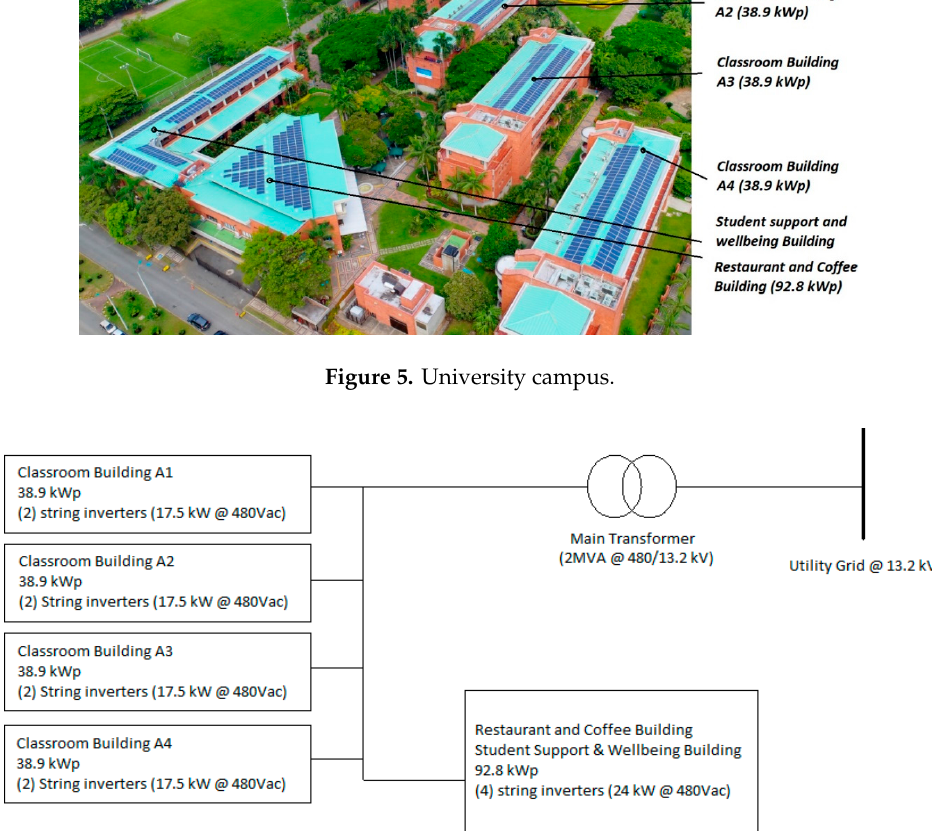
Figure 6. Educational building and canteen—Stage 2.